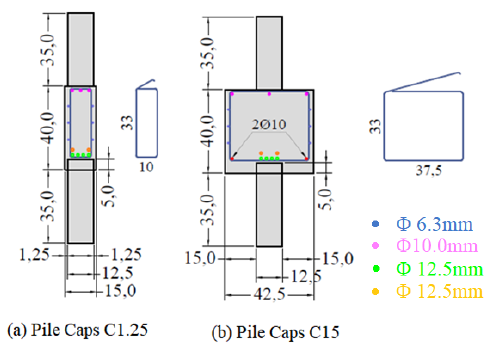
Figure 7. Cross section of models (a) C1.25 and models (b) C15